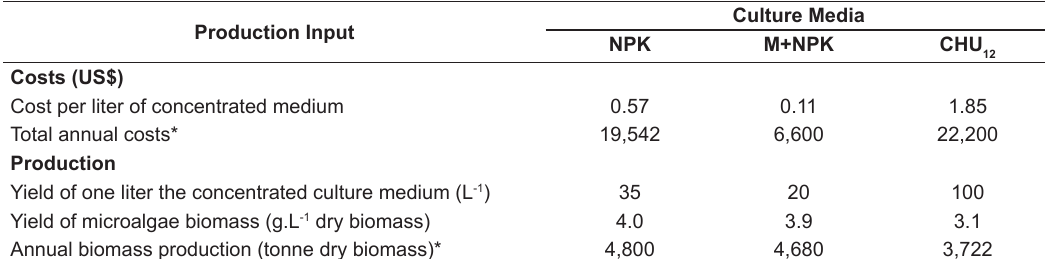
Table 4. Estimation of components cost (US$ dollars) a for 2-L producing 100,000L month 1 (g.L -1 dry biomass)